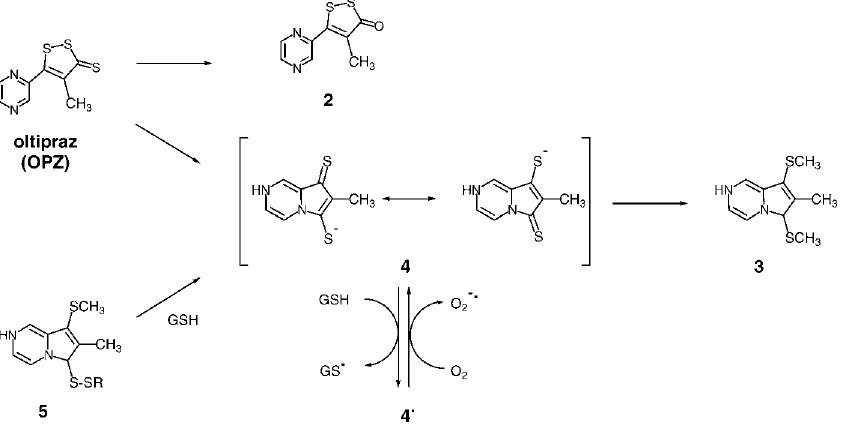
Figure 9. Metabolism of Oltipraz Metabolism of OPZ results in the production of a minor oxo analog (2), and the major dimethylated pyrrolopyrazine (3) through the biological methylation of the intermediate pyrrolopyrazine thione